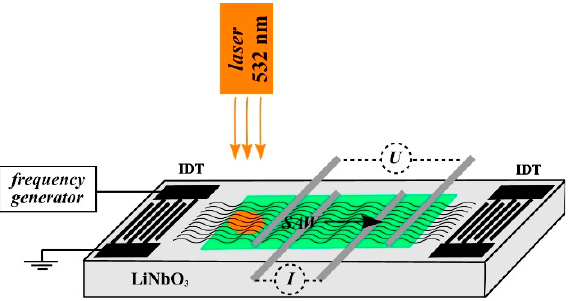
Figure 7. Scheme of a photo-stimulated charge transport in a graphene film by a surface acoustic